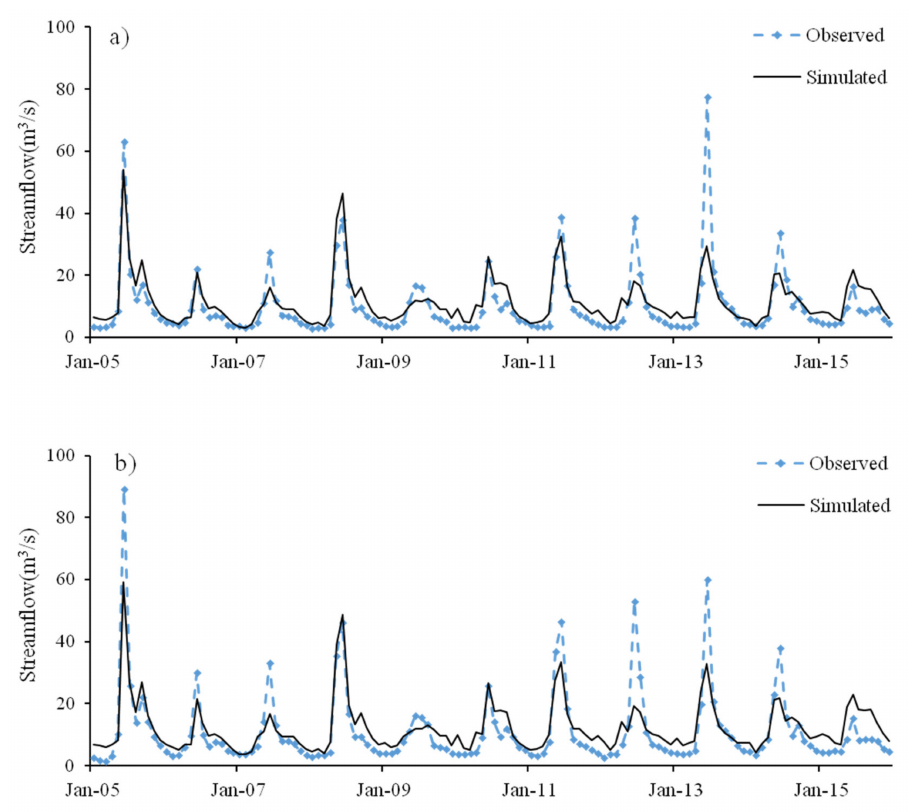
Figure 2. Comparison of simulated and observed monthly streamflow for ( a ) Bragg Creek station and ( b ) Sarcee Bridge